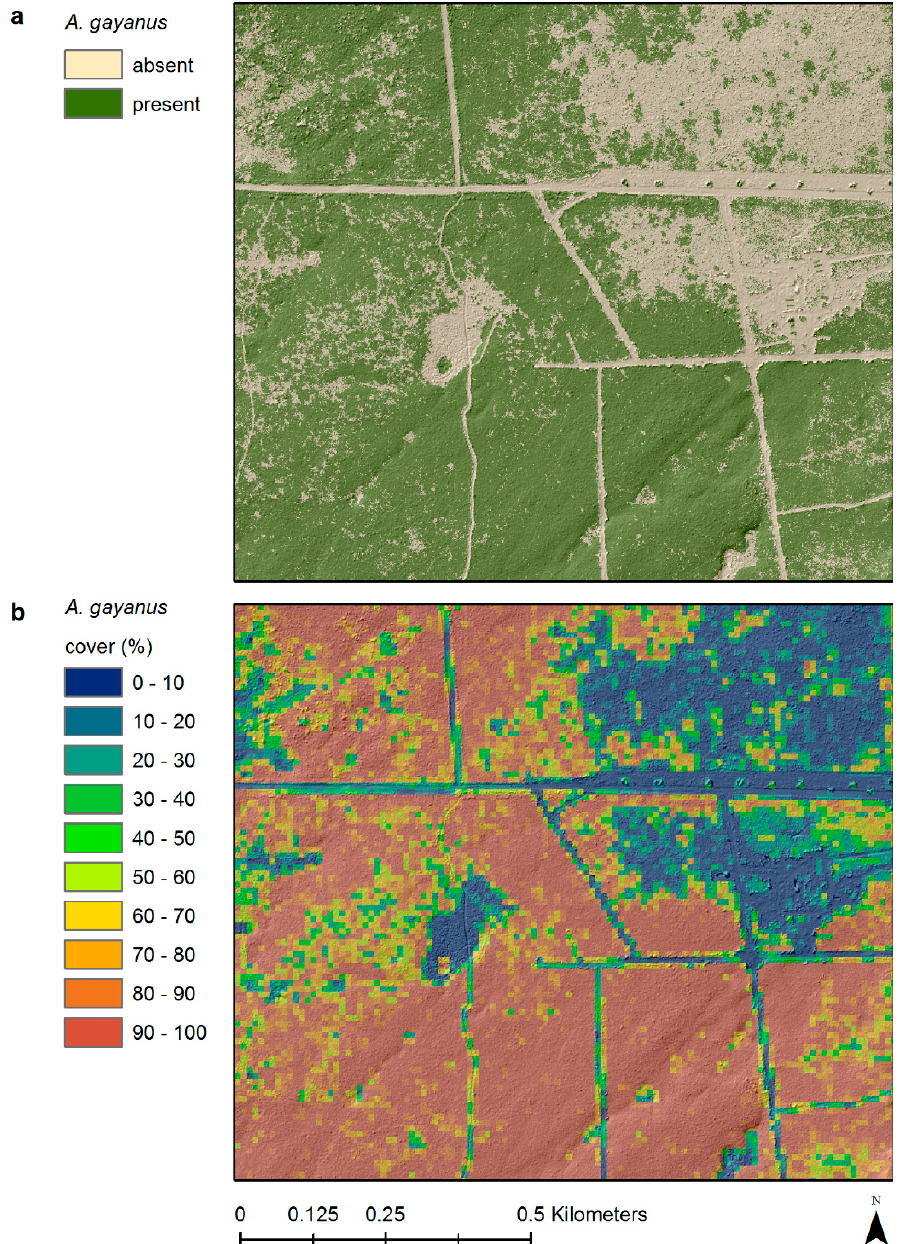
Figure 4. Airborne LiDAR based classification of ( a ) A. gayanus occurrence at 1 m scale, and ( b ) A. gayanus percentage canopy cover at 10 m